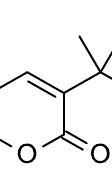
Figure 5. Structure of chalepensin.